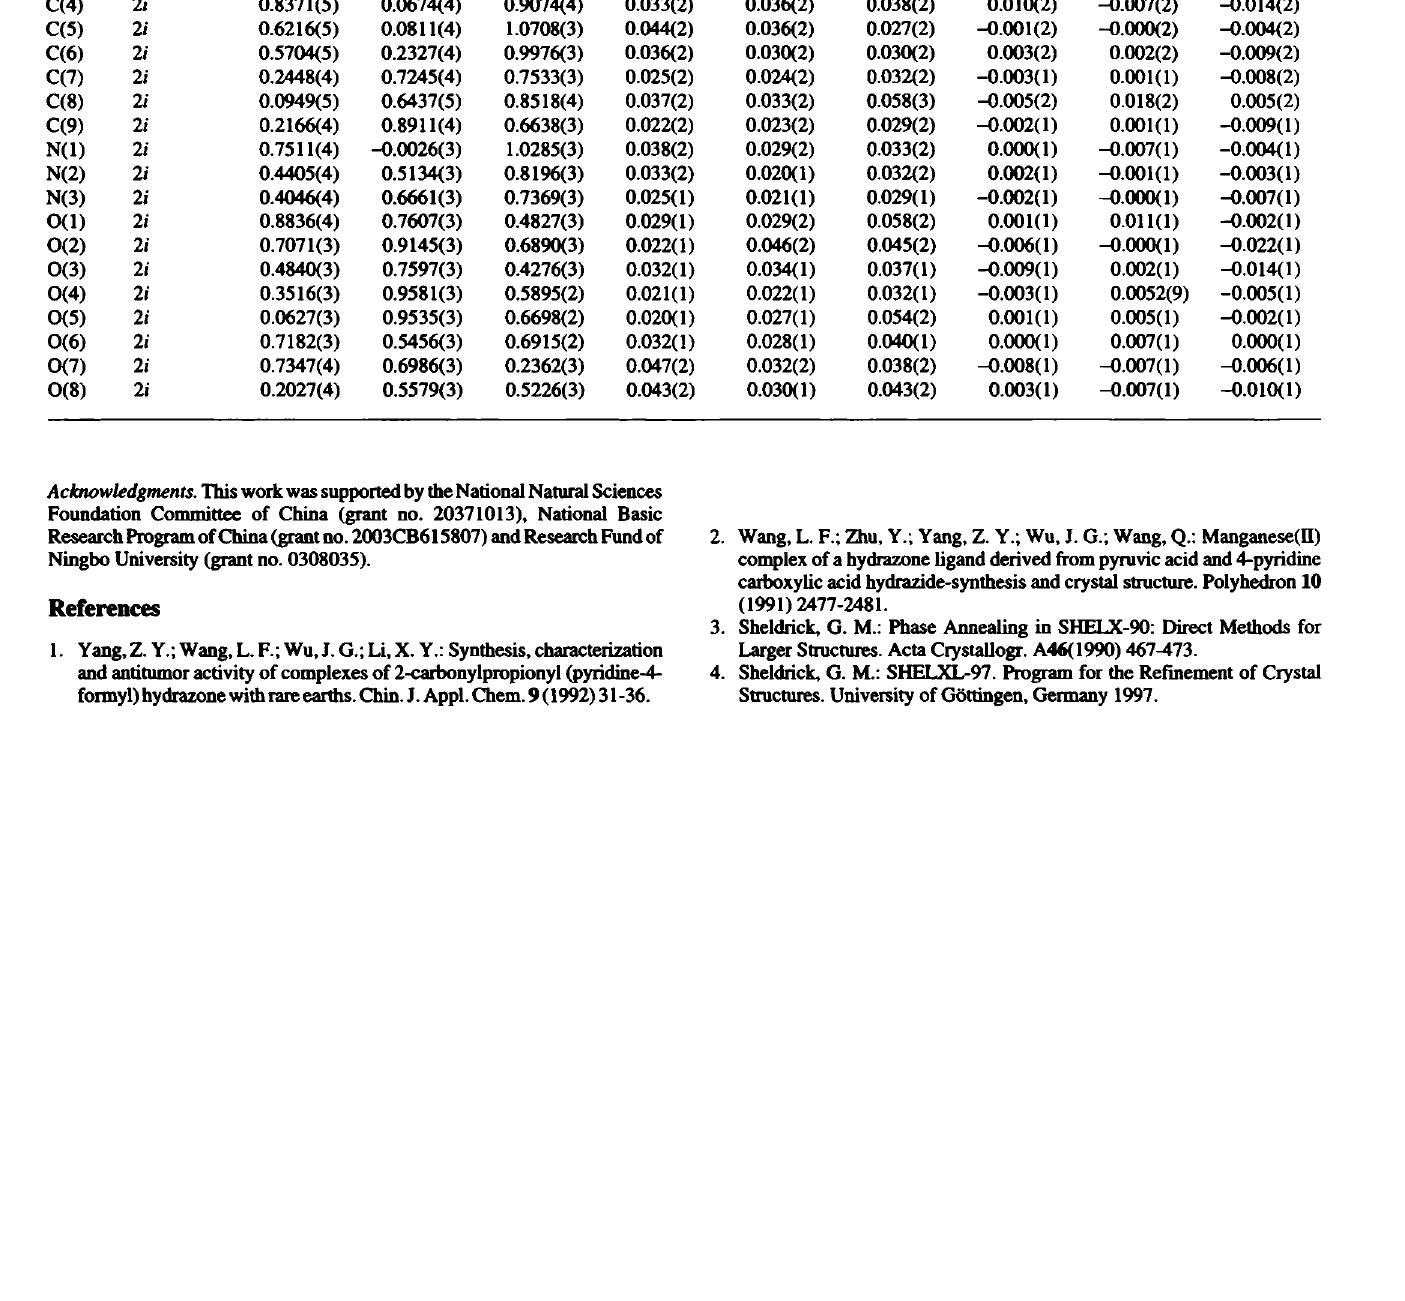
Table 3. Atomic coordinates and displacement parameters (in Ä 2